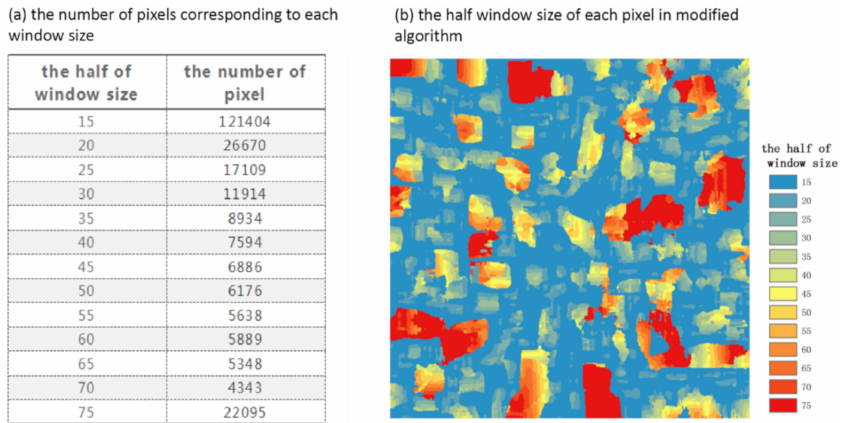
Figure 11. The use of di ff erent window sizes in the algorithm in Jiujiang. ( a ) is statistical table of number of pixels corresponding to each window size and ( b ) is the distribution map of the half window size of each pixel in the modified